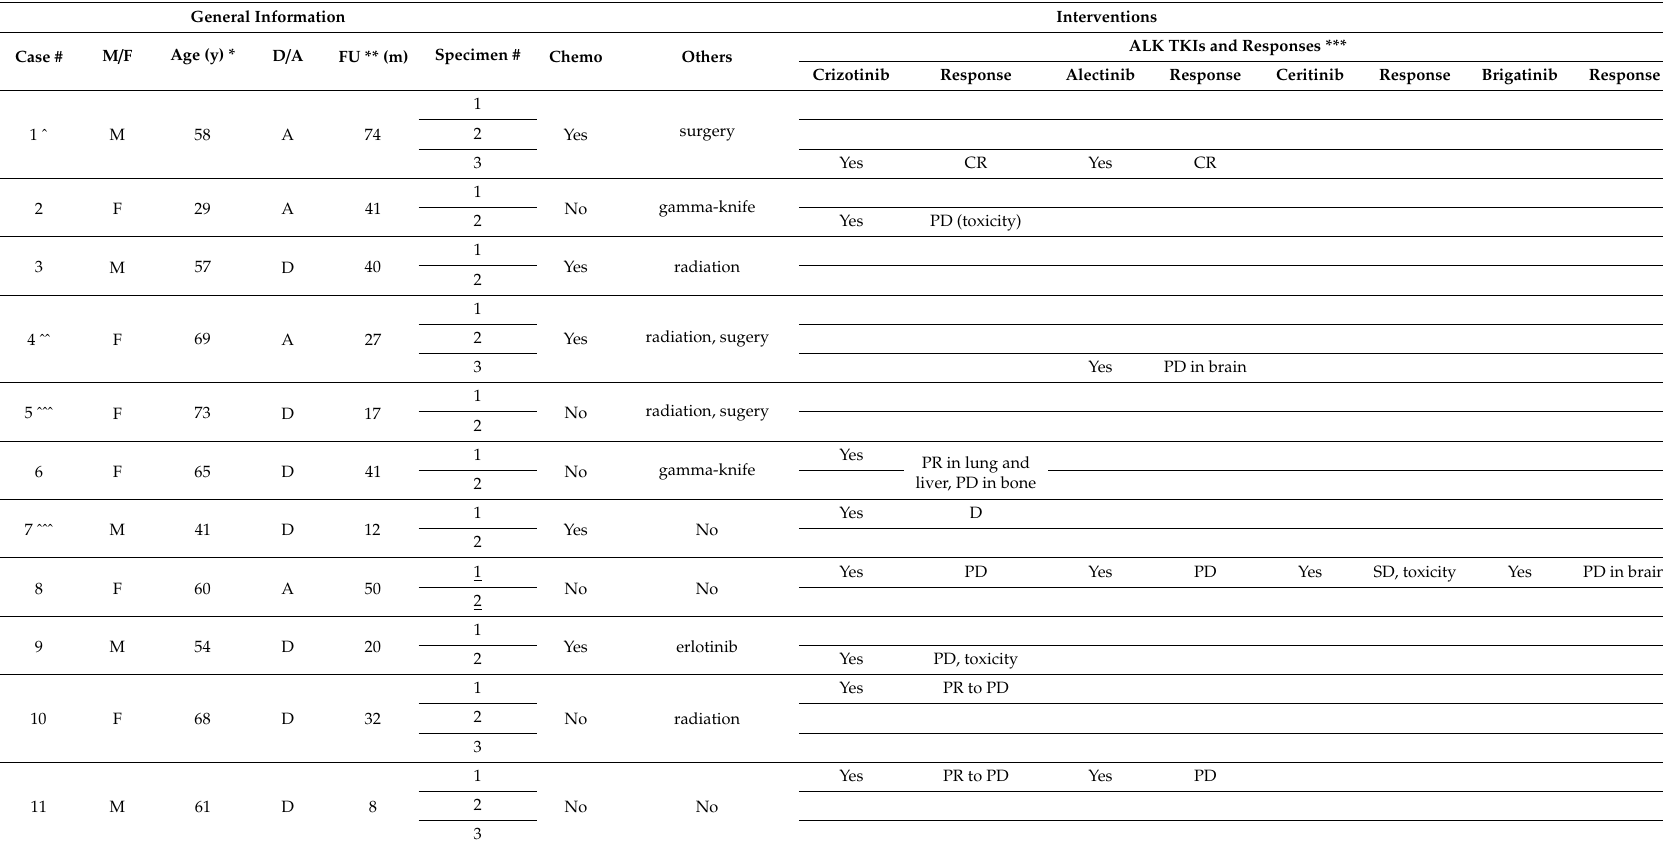
Table 1. General information on lung cancer patients in this